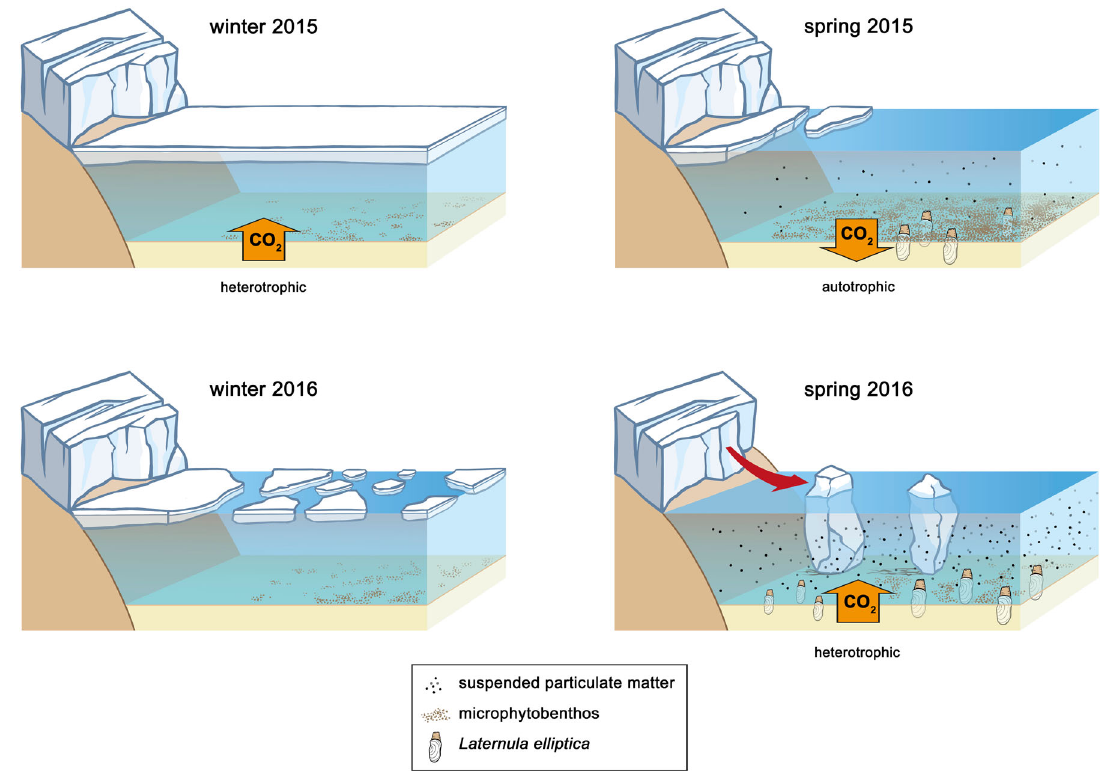
Fig. 5 Schematic overview of the in fl uence of climatic conditions on the marine ecosystem of Potter Cove. El Niño conditions in winter and spring 2015 re fl ect a ‘ past scenario ’ and La Niña conditions in winter and spring 2016 re fl ect a possible ‘ future scenario ’ . Benthic metabolism is indicated as difference between gross primary production (GPP) and community respiration